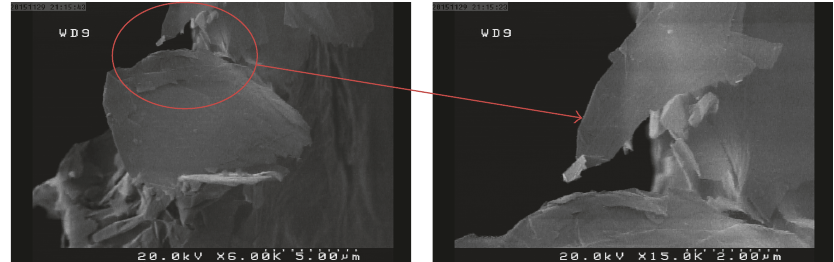
Figure 3: SEM images of graphene oxide sheets produced by modified Hammers method from graphite flakes.